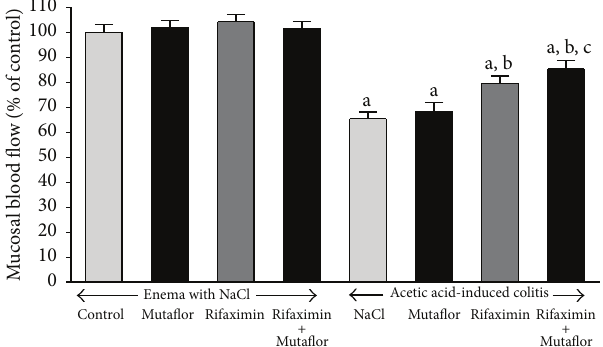
Figure 3: Influence of E. coli Nissle 1917 (Mutaflor) and rifaximin on mucosal blood flow in the colon in rats without or with acetic acid- induced colitis. Mean value ± SEM. 𝑁 = 8 animals in each experimental group. a 𝑃 < 0.05 compared to control saline-treated rats without induction of colitis; b 𝑃 < 0.05 compared to colitis + NaCl; and c 𝑃 < 0.05 compared to colitis +